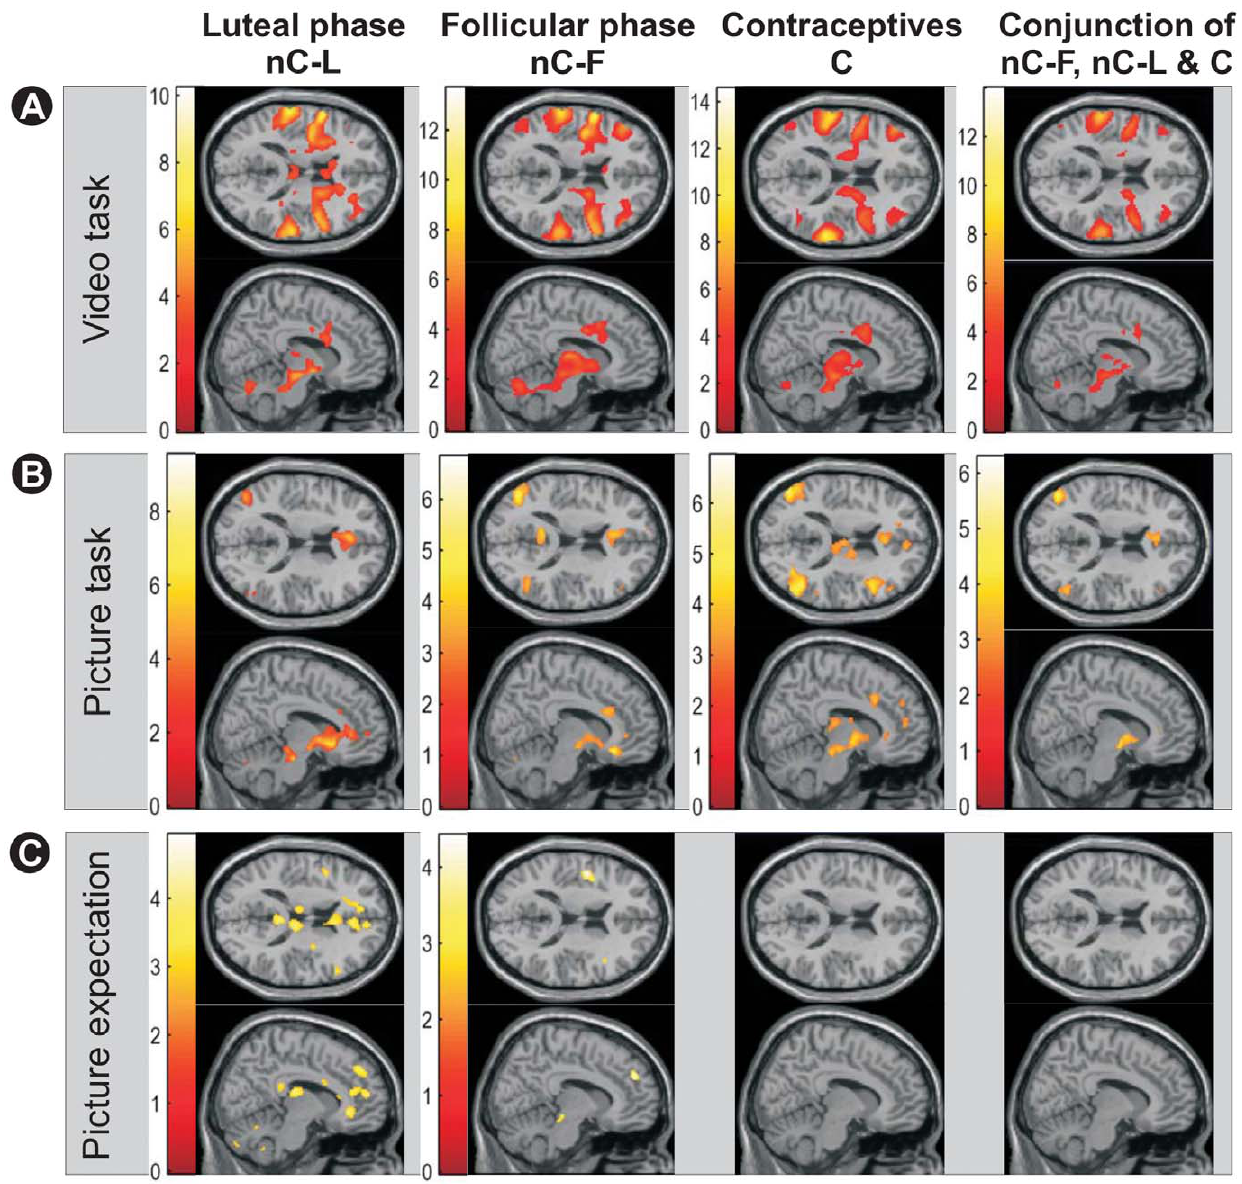
Figure 1. Differential brain activation contrasting erotic minus non-erotic stimulation. Depicted are contrasts from experimental runs with video (A), picture (B) and picture expectation (C) stimuli during luteal and follicular phase of the menstrual cycle and under oral contraceptives. The rightmost panel depicts the conjunction of the three conditions. For demonstration purposes, all thresholds were set at p , 0.005 uncorrected. Even at such a more lenient threshold, no differential brain activation was found under contraceptives upon picture